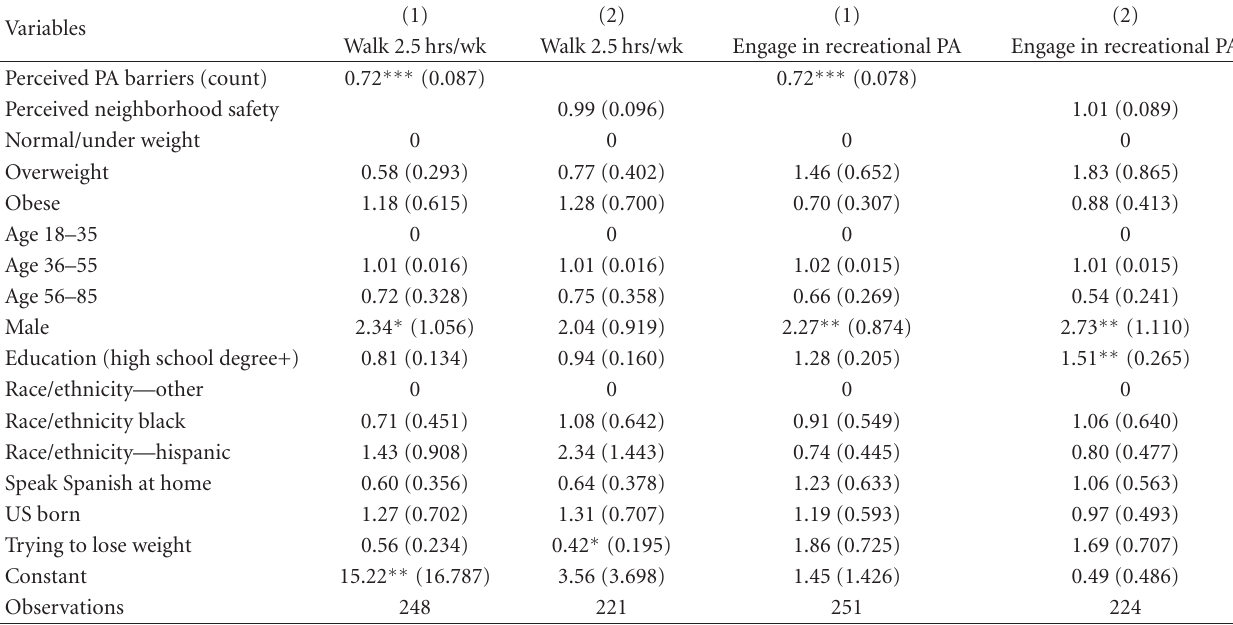
Table 4: Perceived barriers and safety concerns and engagement in routine and recreational physical